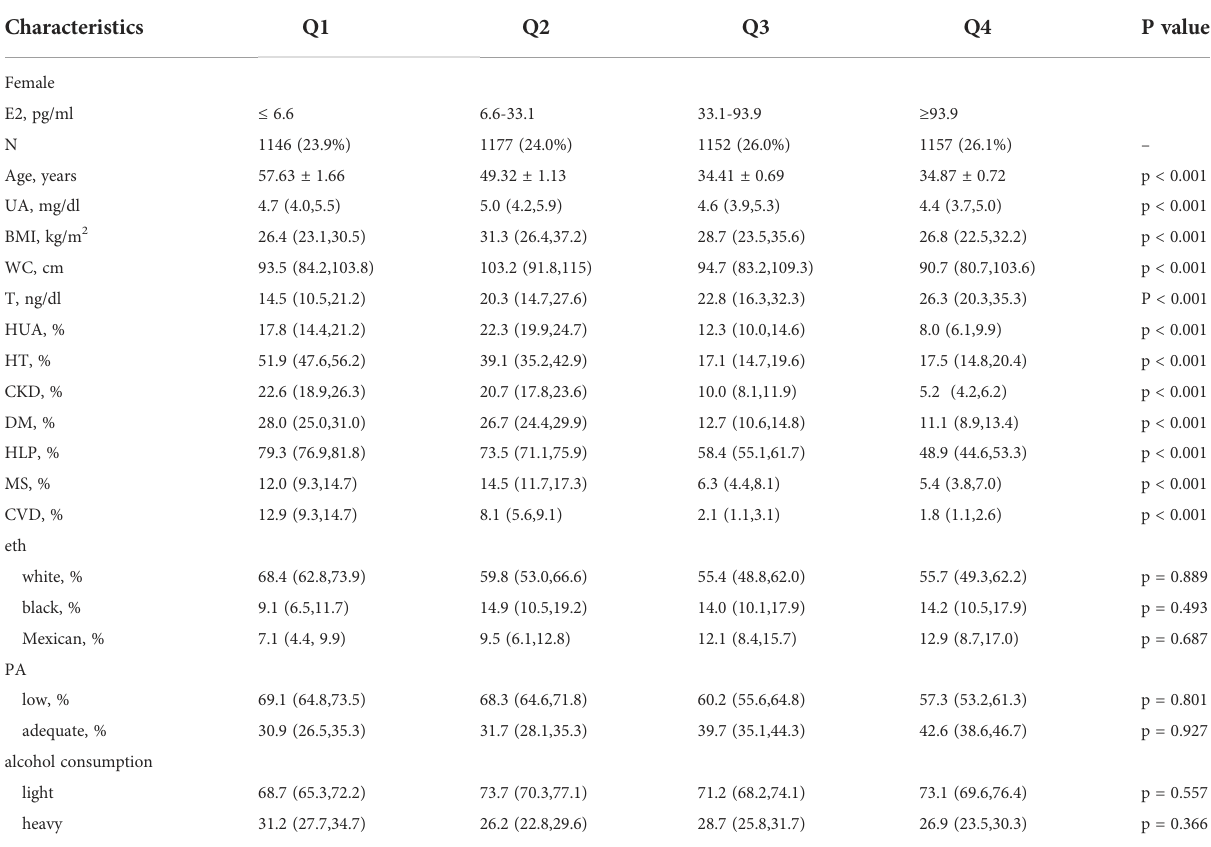
TABLE 1 General characteristics of female participants by E2 quartiles.